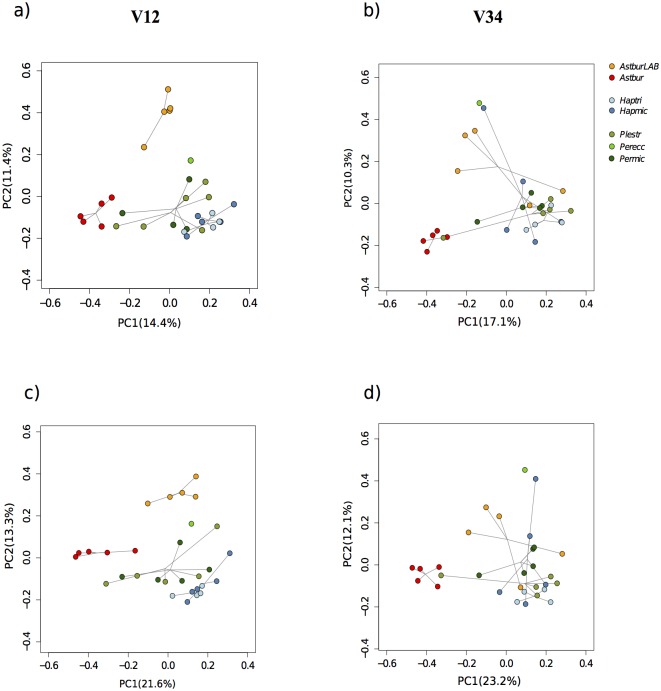
Principal coordinate analysis of beta diversity estimates for whole microbial communities of the 30 specimens analyzed (individual circles) based on binary Jaccard (a, b) and unweighted unifrac distances (c, d) for V12 (a, c) and V34 (b, d).Lines connect circles with the species centroid; species are colour-coded (see Legend). Despite few discrepancies between libraries, all plots illustrate two main clusters: the member of the tribe Tropheini, Astbur (in red), and the Perissodini species (Haptri, Hapmic, Permic, Perecc and Plestr), which largely superimpose in their microbiota space. The laboratory species AstburLAB carries a remarkably distinct microbiota from its wild conspecifics (Astbur).